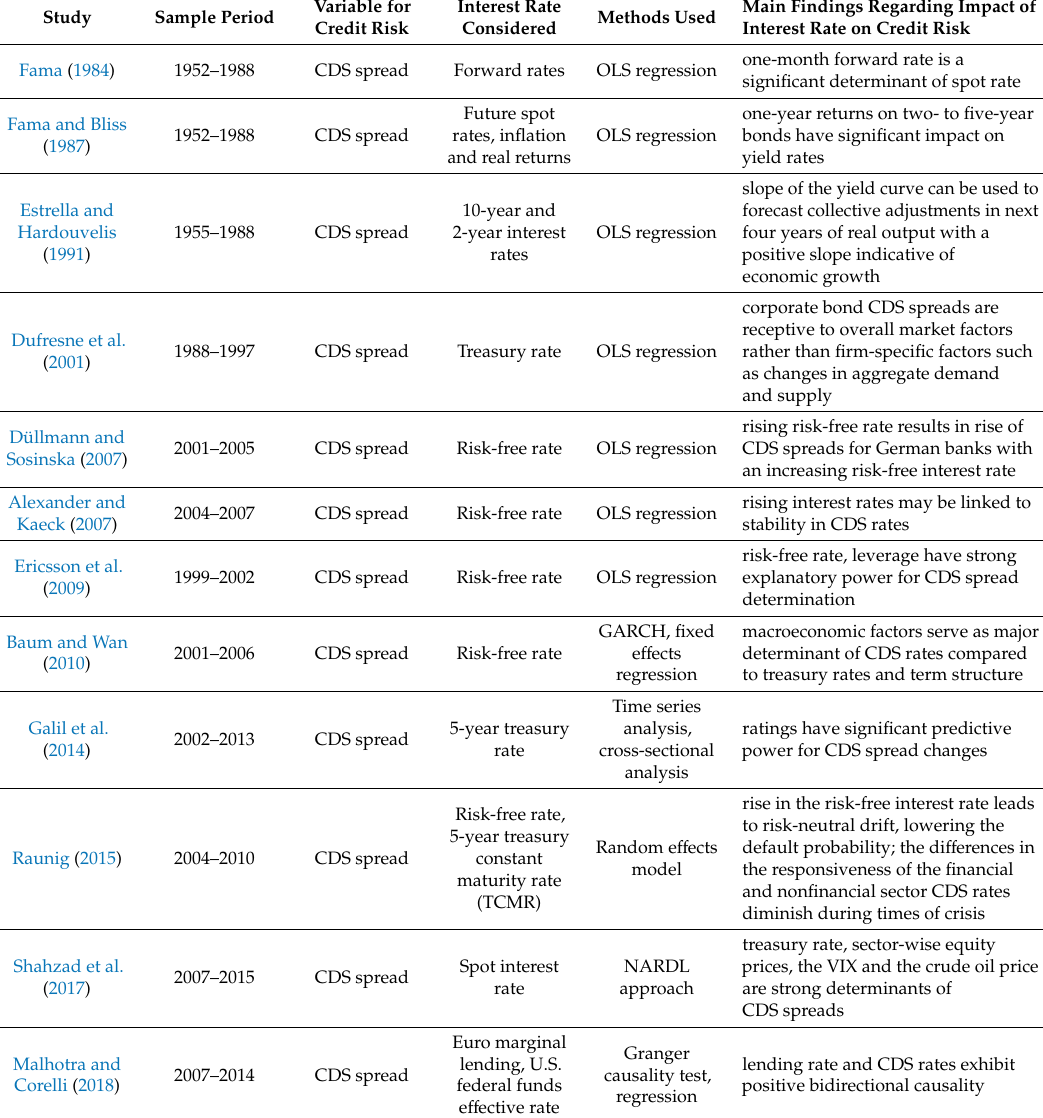
Table 1. Studies on credit risk using credit default swap premia. CDS: credit default swap; OLS: ordinary least